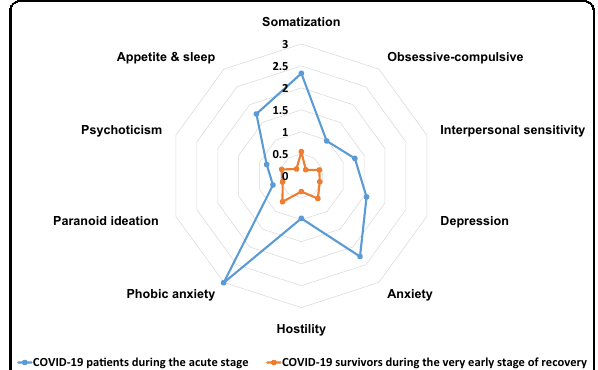
Fig. 2 Severity of psychiatric symptoms of COVID-19 patients and survivors. Radar map depicting the severity of psychiatric symptoms of COVID-19 patients and survivors, as measured by Cohen ’ s d values.